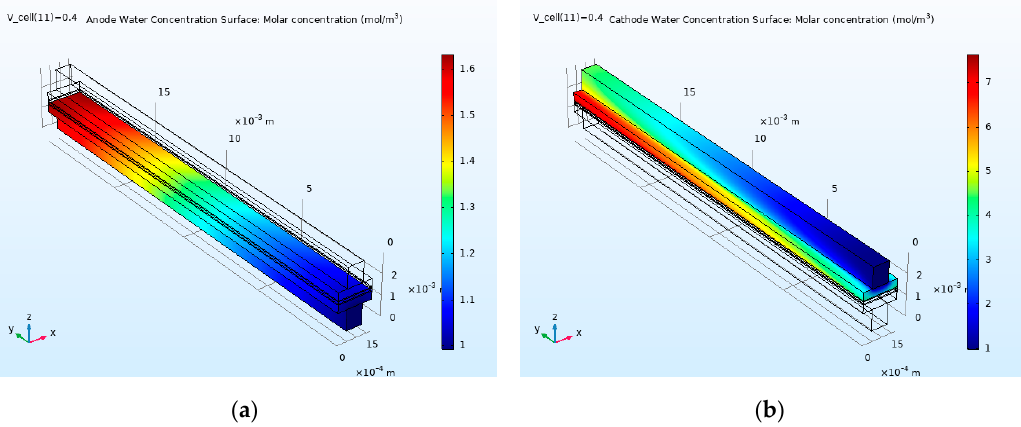
Figure 7. Concentration of water along ( a ) the anode flow channel and ( b ) the cathode flow channel operating at 180 °C and 0.4 V (mol/m 3 ).